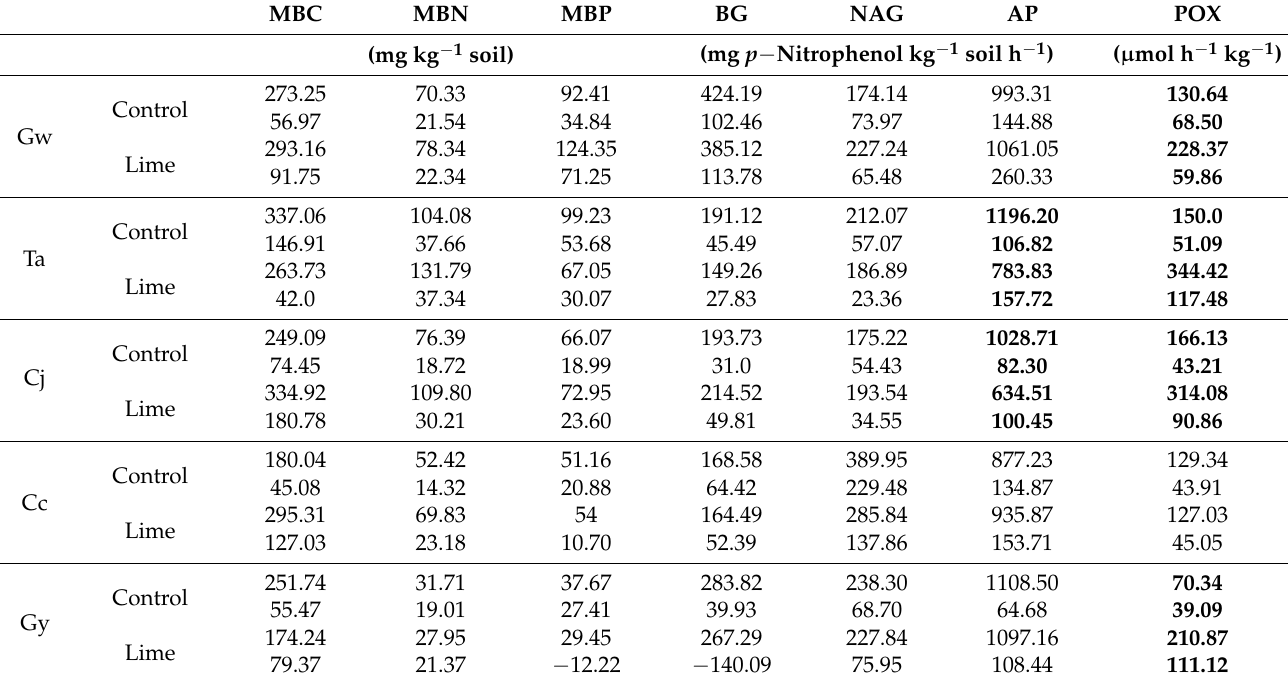
Table 2. Soil microbial and enzymatic properties of study sites.